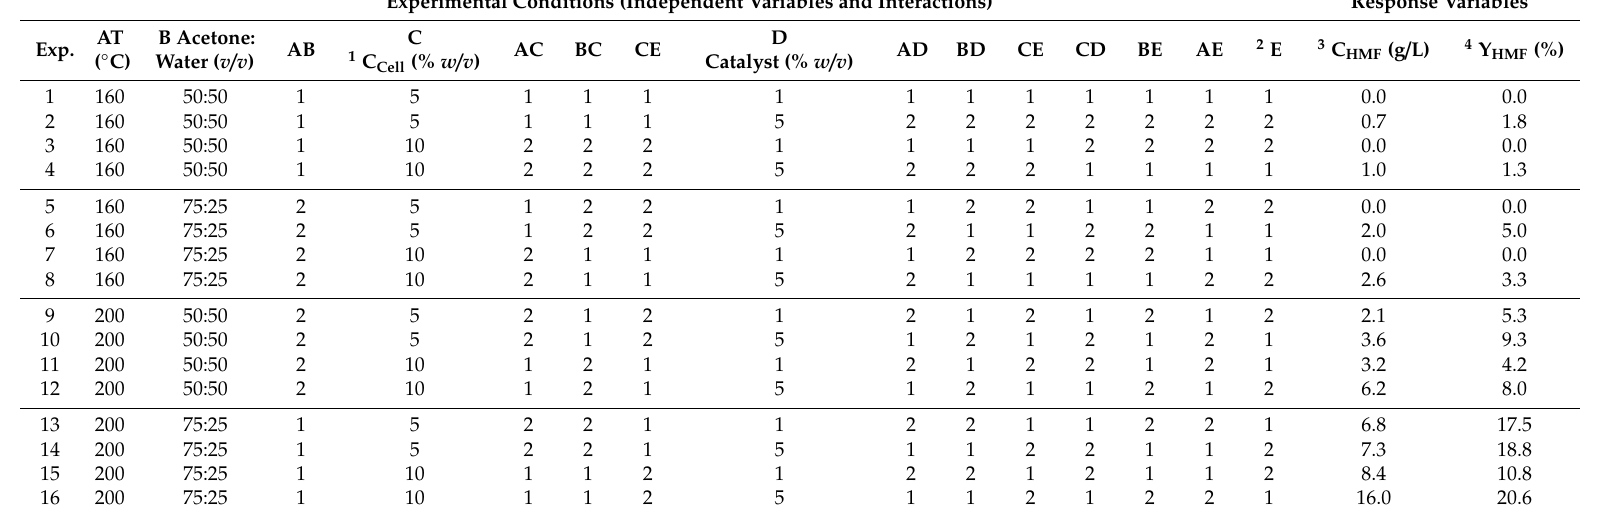
Table 1. Taguchi’s L 16 orthogonal array to evaluate the e ff ects of temperature, acetone:water ratio, cellulose load and catalyst concentration on 5-hydroxymethylfurfural (HMF) production from